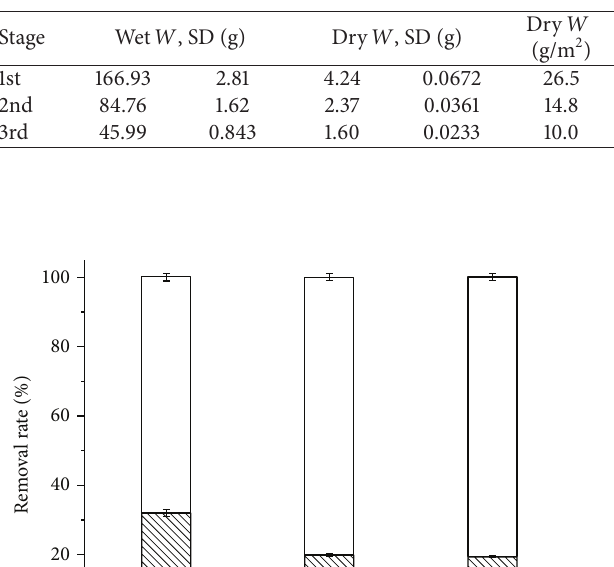
Table 3: Weight ( 𝑊 ) and water ratio of biofilm on single disc and removal percentages in different stages.